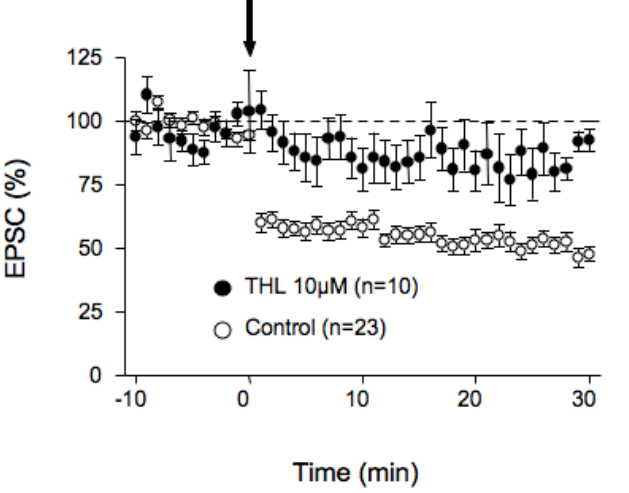
Figure 8. Effects of blocking eCB reuptake on sub threshold tetanus. Averaged time courses of the experiments in which the 5 min at 10 Hz protocol was given in control ACSF (open circles) of after pre-treatment with the eCB reuptake blocker AM404 (20 m M, black circles).